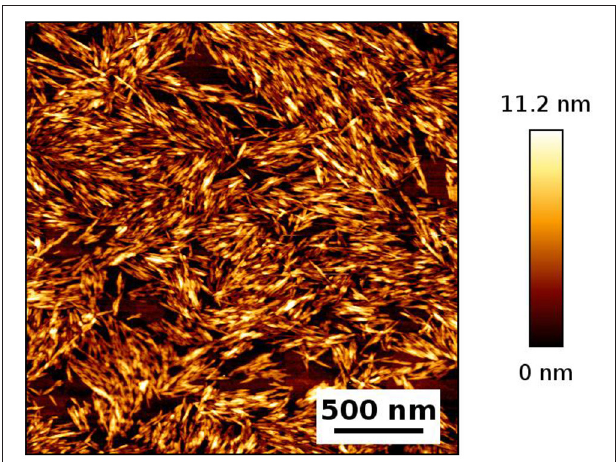
FIGURE 1 | AFM Image of CNC deposited on a glass surface and dried.